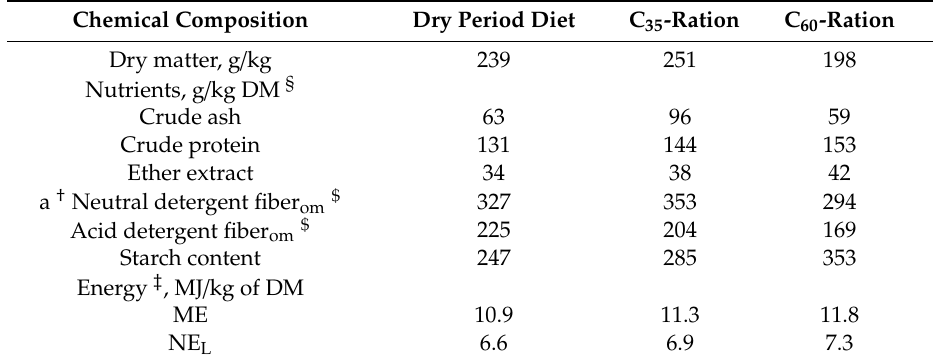
Table 2. Chemical components of the dry period diet, as well as of the C 35 - and C 60 -ration during the experimental period from day 21 antepartum until day 70 postpartum. Chemical